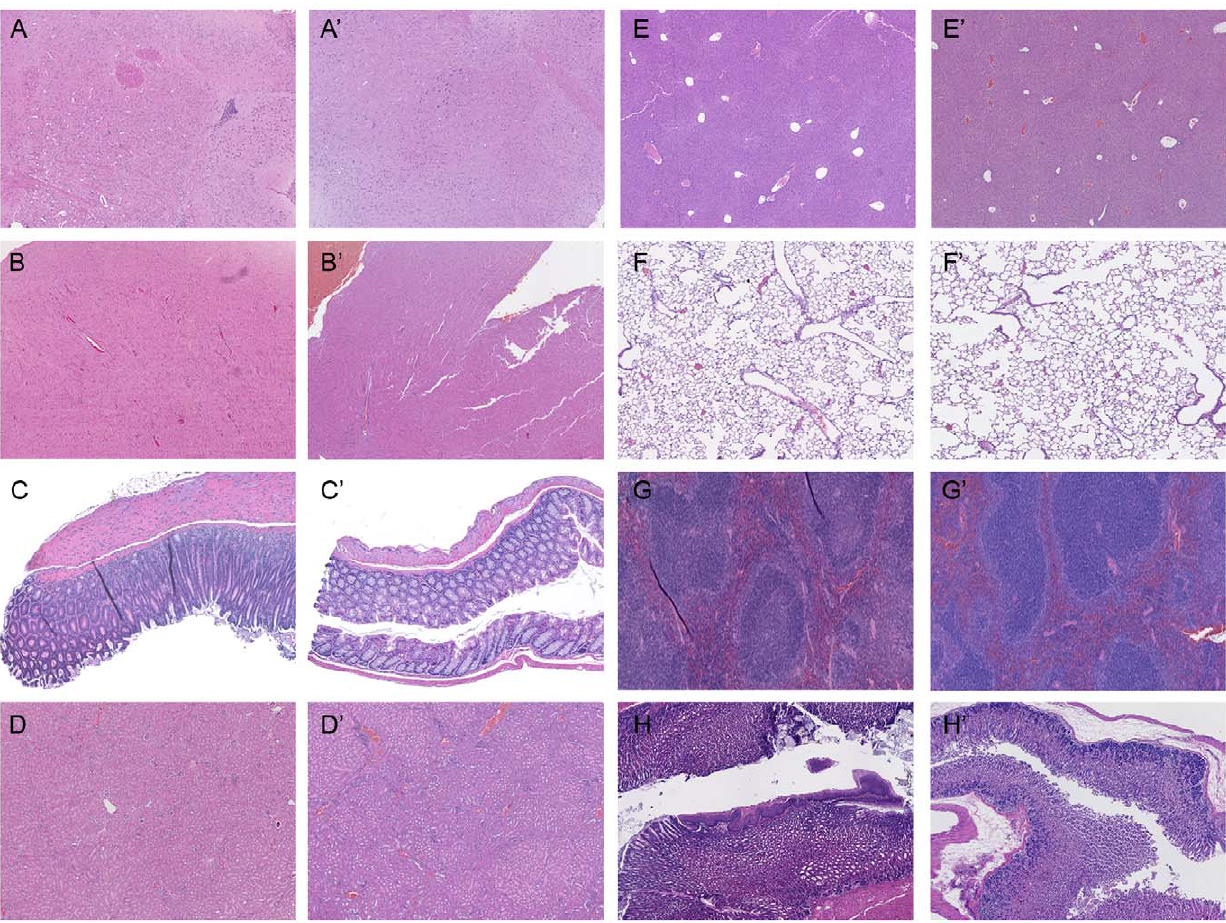
Figure 7. Adult tissues of rescued Lamc2 KO mice appear grossly similar to Lamc2 WT controls. Paraffin-embedded tissue sections of adult Lamc2 WT (A–H) and rescued Lamc2 KO (A’–H’) mice were stained with H&E. Despite a lack of laminin c 2 expression, the brain (A, A’), heart (B, B’), intestine (C, C’), kidney (D, D’), liver (E, E’), lung (F, F’), spleen (G, G’), and stomach (H, H’) appear grossly similar between the Lamc2 WT and rescued Lamc2 KO